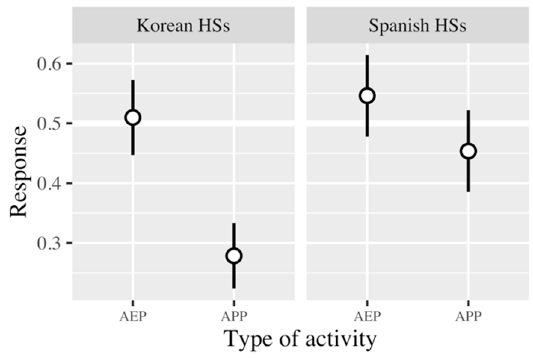
Figure 2. Activity/material type preferences across HL groups.